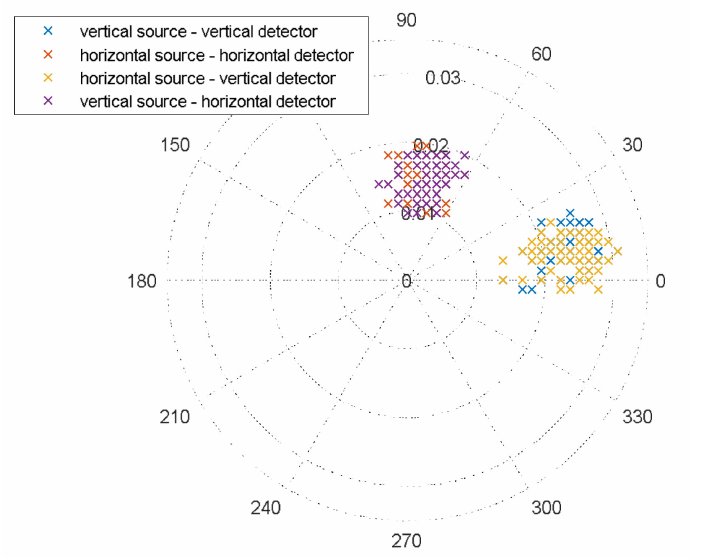
Figure 3. Polarization diagram of the received signal relative to the transmitted signal unit for a rough surface and free meadow propagation (radial axis is a dimensionless variable; linear polarization; number of marks for each